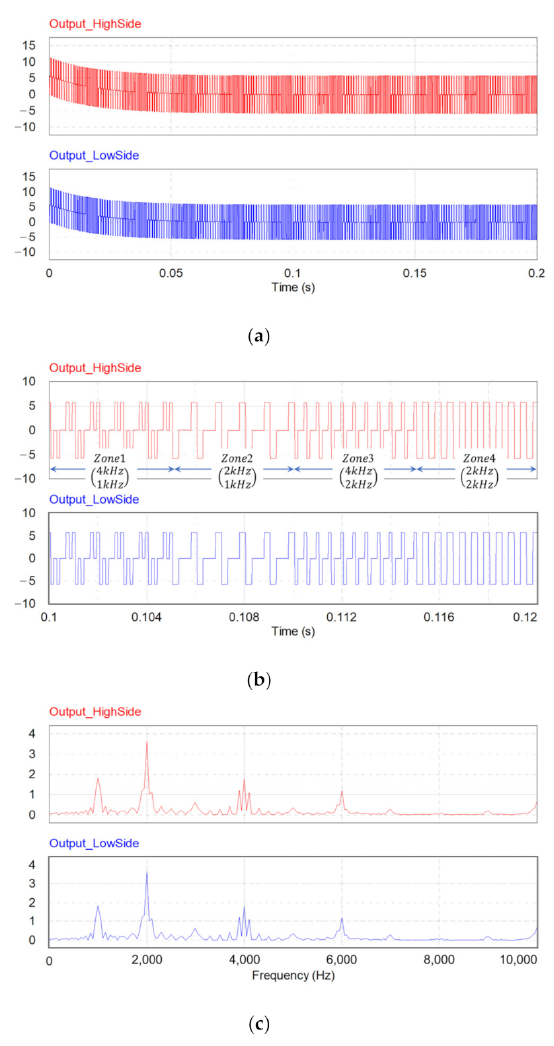
Figure 9. The high side and low side frequency overlap under normal state: ( a ) frequency variation characteristics; ( b ) expansion of the frequency variation characteristics; ( c ) FFT characteristics.